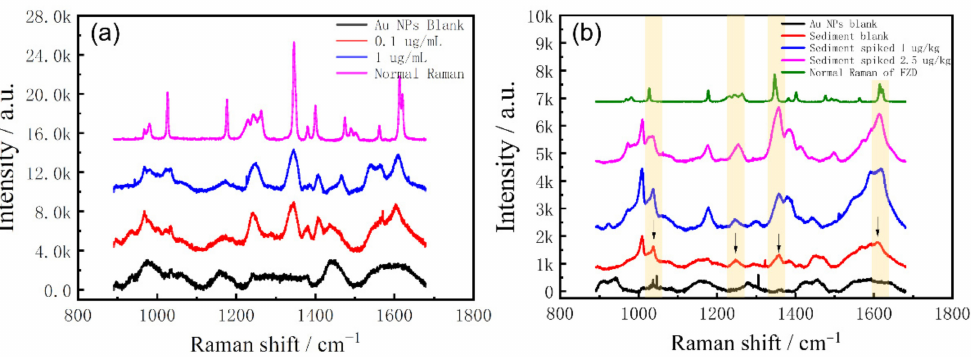
Figure 5. ( a ) SERS and Raman spectra of FZD; ( b ) SERS spectra of HPLC effluent from the